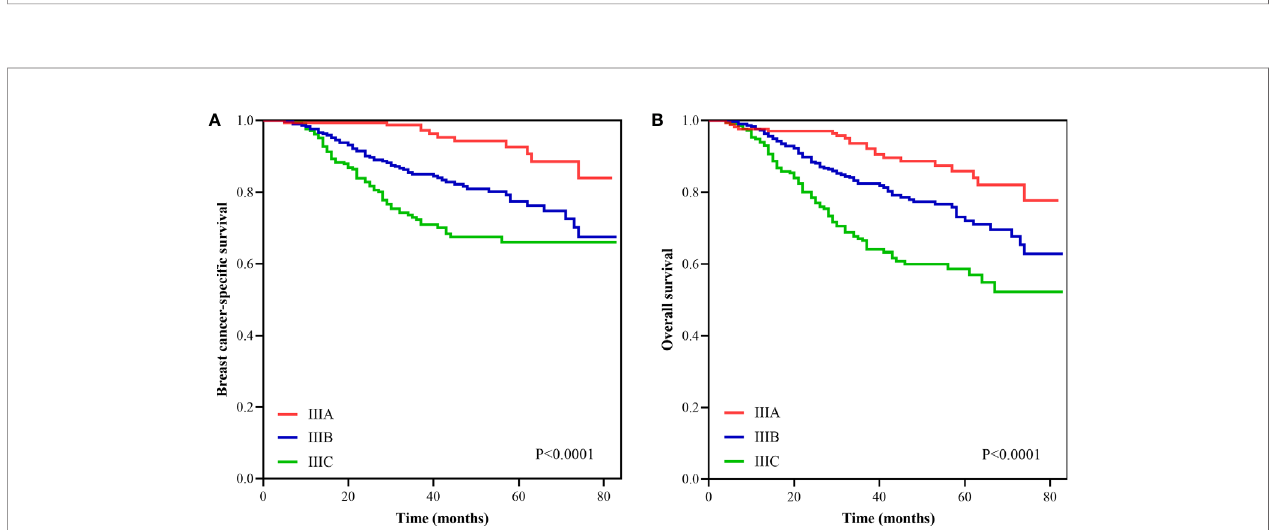
FIGURE 2 | Survival curves according to different stages using the 8th edition of the American Joint Committee on Cancer pathological prognostic staging system ( A , breast cancer-speci fi c survival; B , overall